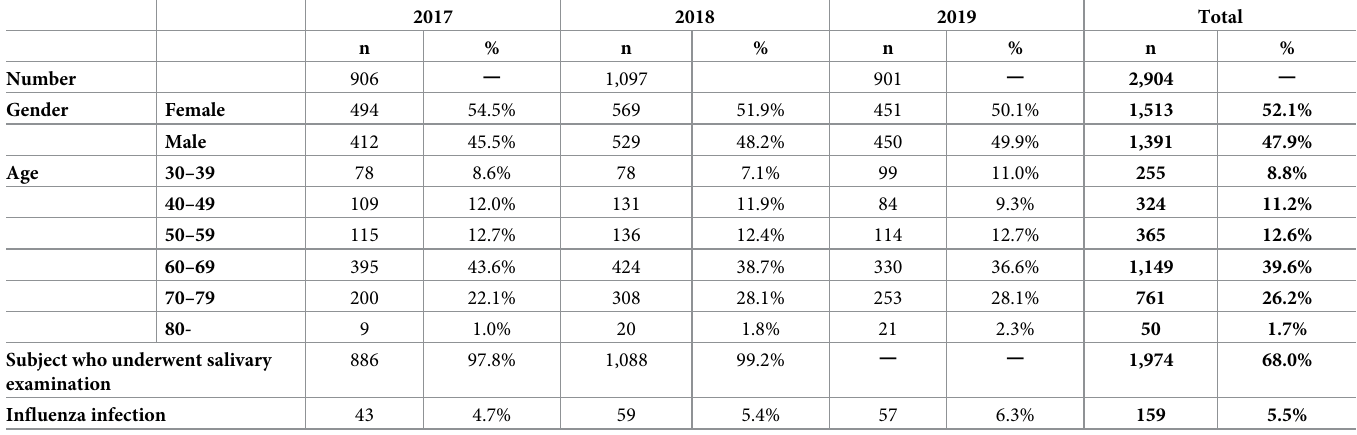
Table 1. Characteristics of the studied